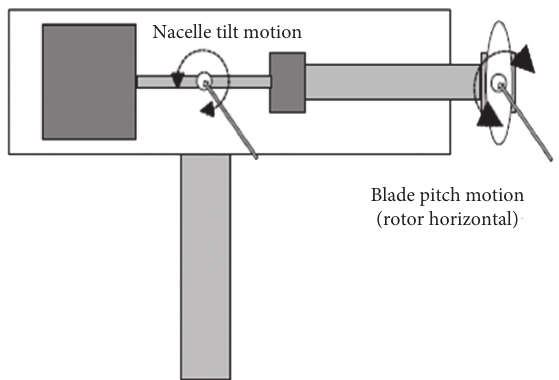
Figure 1: Blade pitch degree of freedom.